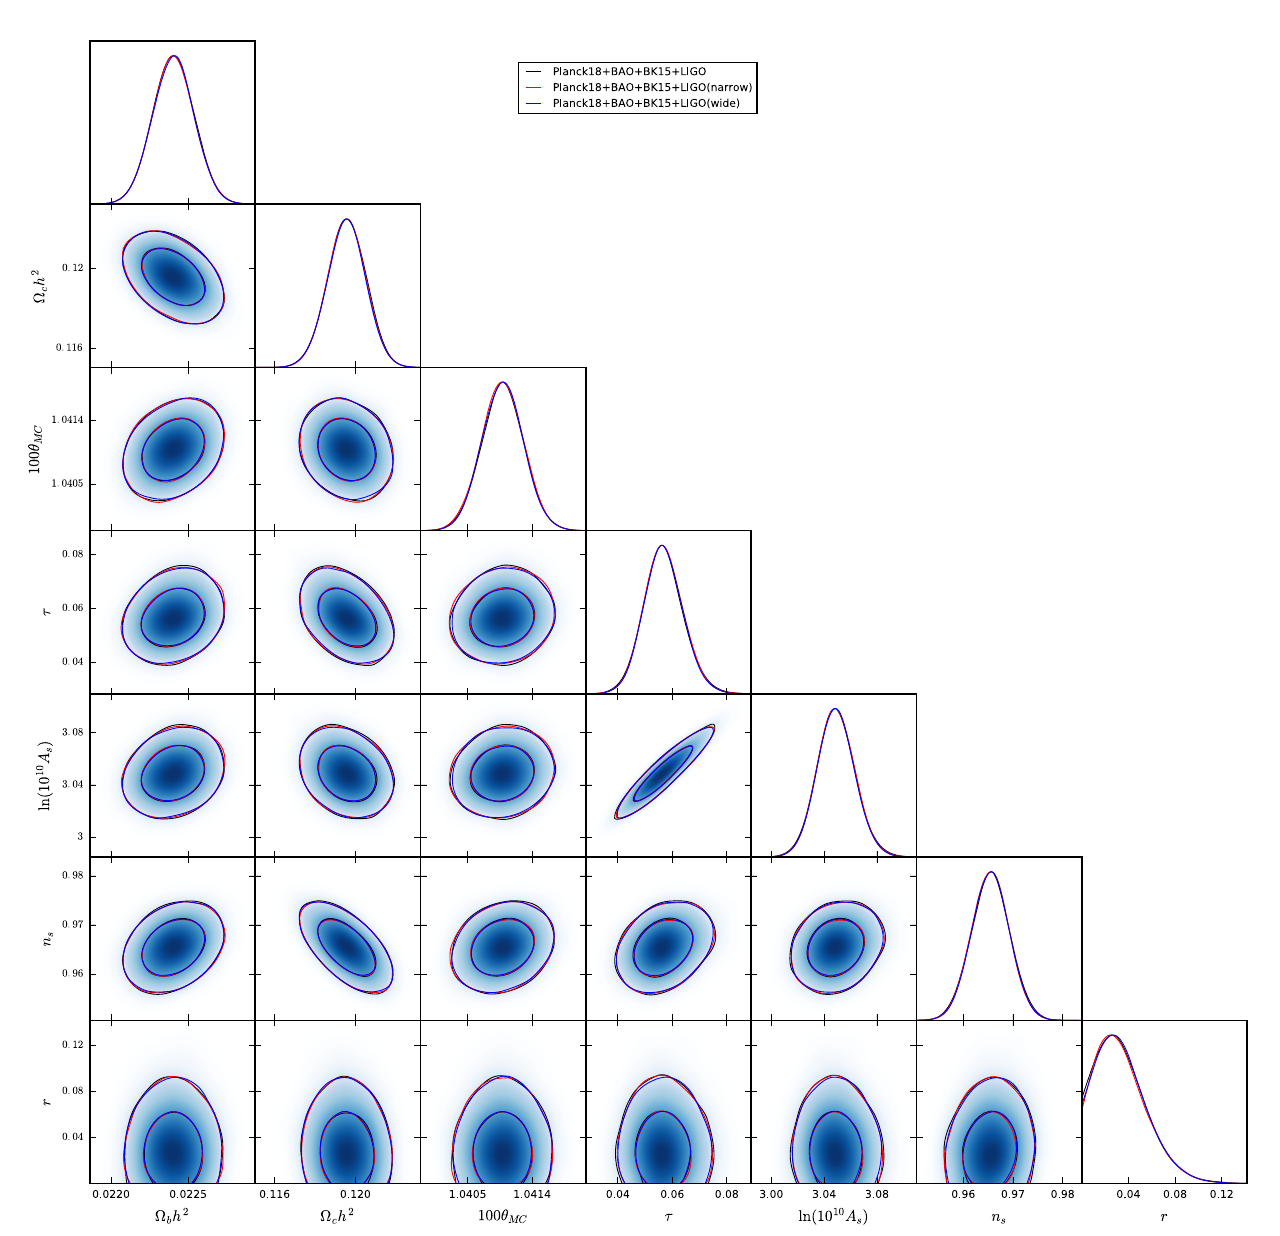
Fig. 1 The contour plots and the likelihood distributions for the cosmological parameters in the (cid:2) CDM+ r model at the 68% and 95% CL from the combinations of Planck18+BAO+BK15+LIGO, Planck18+BAO+BK15+LIGO n , Planck18+BAO+BK15+LIGO w ,